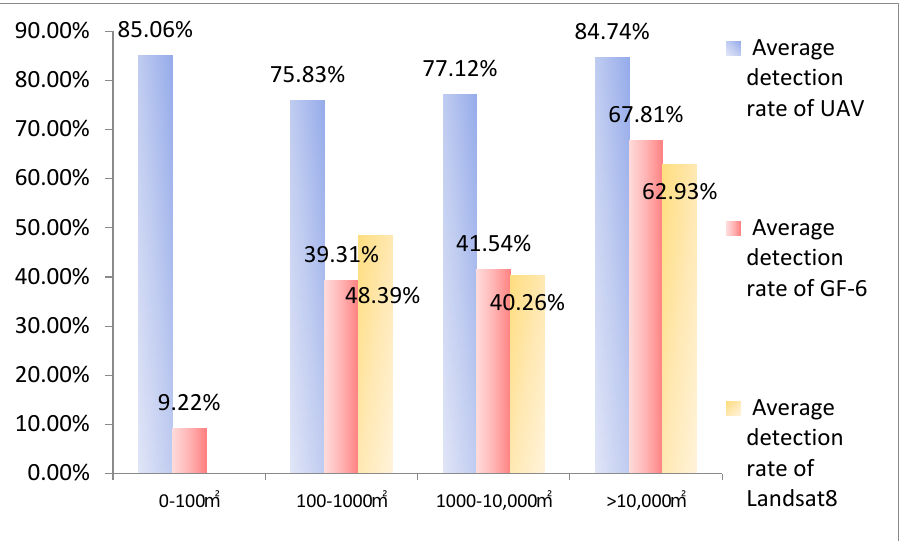
Figure 6. Average detection rate of each image.